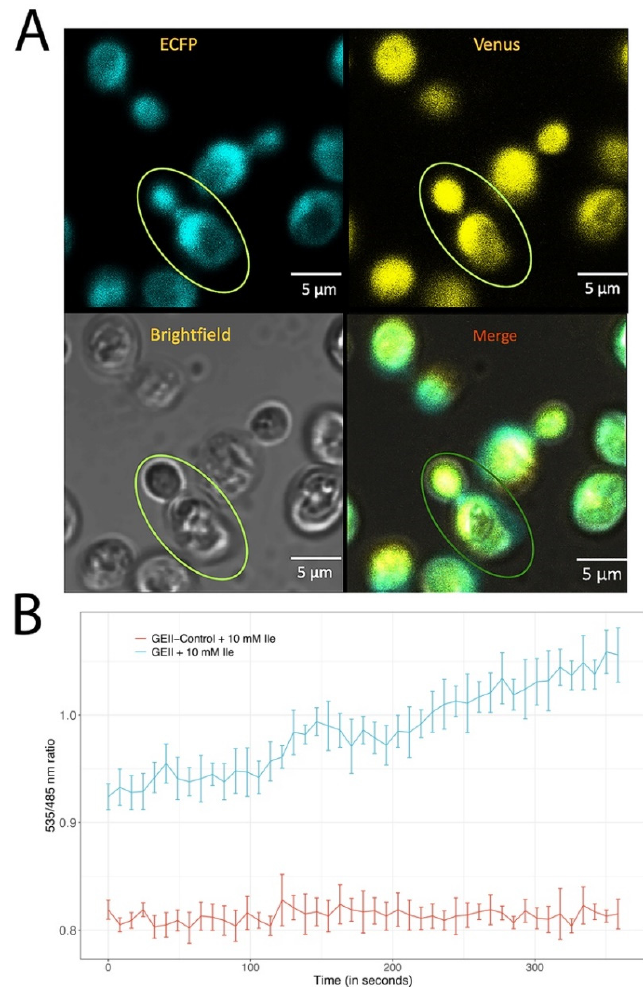
Figure 7. Live cell imaging of isoleucine in yeast cells. ( A ) GEII expression in yeast cells ( S. cerevisiae ) showing the confocal images; the selected region in green oval indicates the region of interest (ROI). ( B ) Ratiometric measurements from the GEII sensor in yeast cells when 10 mM of isoleucine was added to cells expressing GEII and GEII-control. Error bars indicate standard deviation in readings from three independent experiments. Scale bar: 5 µ M.